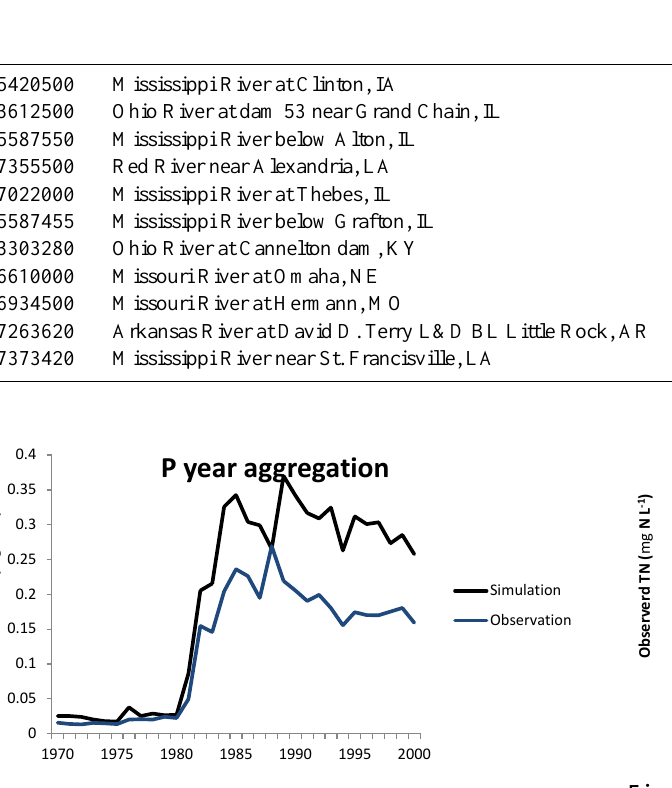
Figure 9. Comparison of simulated total N and P concentration with the EEA data set for the period 1970–2000 (EEA, 2013). (a) N con- centration for all stations, rivers and years; (b) P concentration for all stations, rivers and years; (c) mean N concentration of all years per station; (d) mean P concentration of all years per station; (e) mean N concentration of all rivers per year; (f) mean P concentra- tion of all rivers per year. Please note that the European coverage is not constant and the trend is not representative of European rivers, because the number and location of stations has changed in time, causing changes in the trend. The 1:1 lines are also shown in pan- els (a–d) . Comparison of modeled and observed concentrations for all individual EEA stations is in the Supplement.